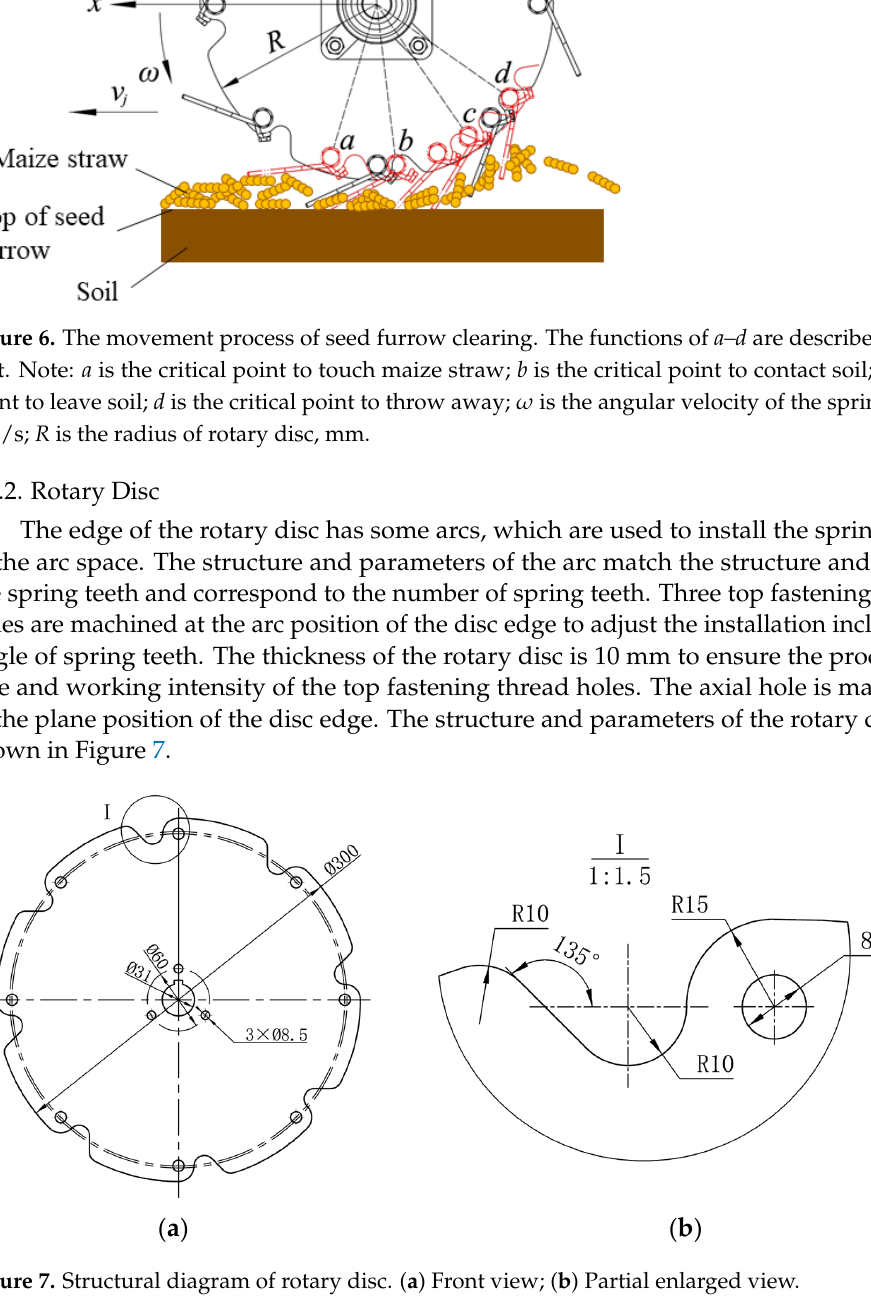
Figure 7. Structural diagram of rotary disc. ( a ) Front view; ( b ) Partial enlarged view.